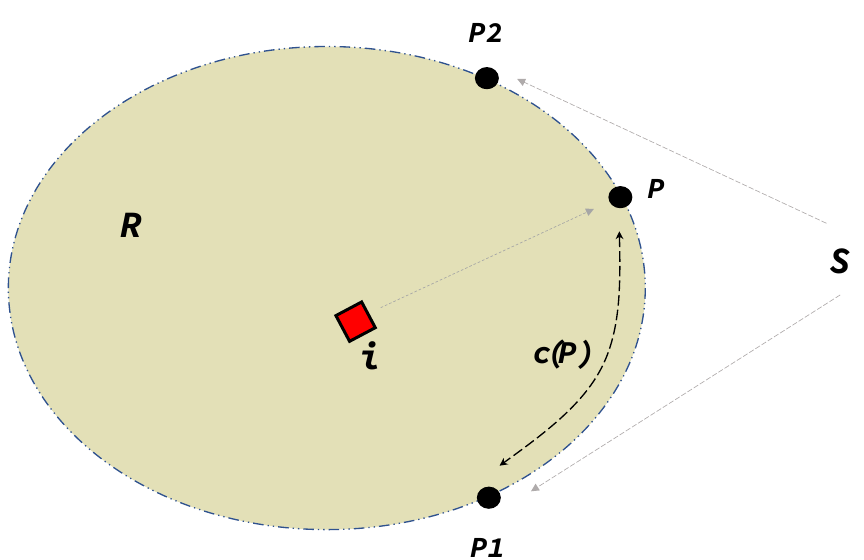
Figure 1. R : The closed convex planar region, S : The segment of the boundary needs to be protected, c ( P ) : The curvilinear